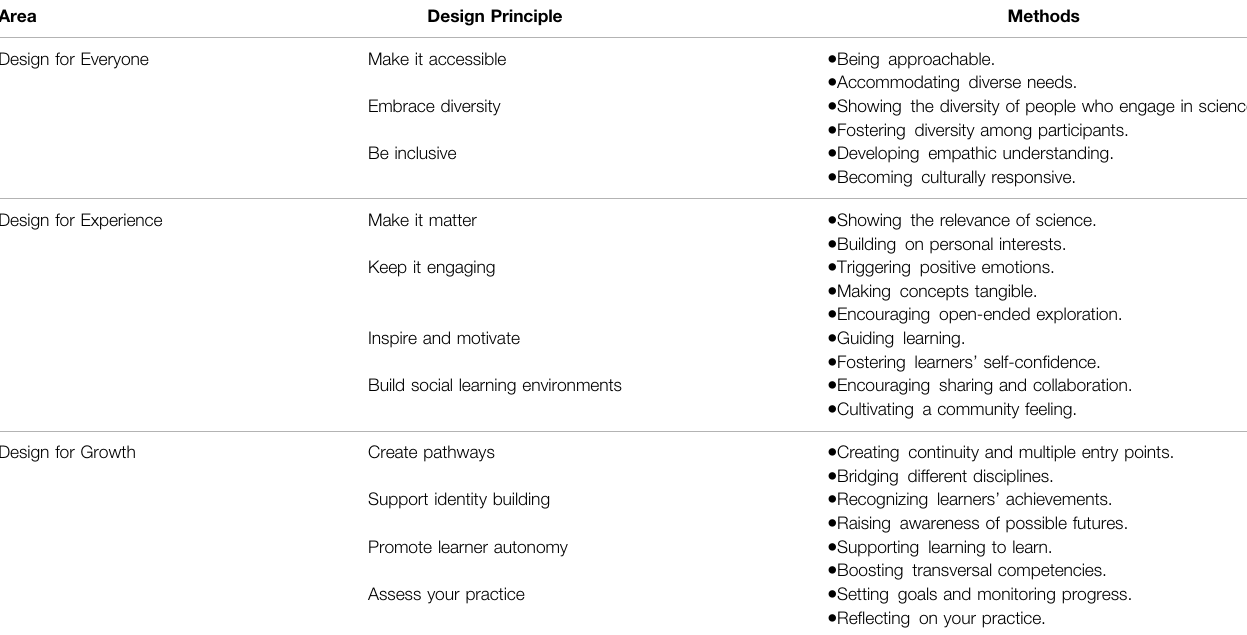
TABLE 2 | Design principles for supporting science education in out-of-school settings.